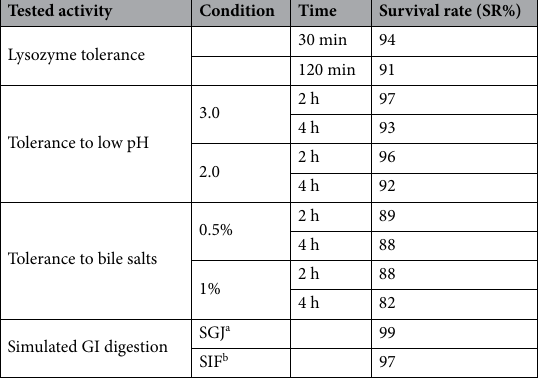
Table 1. Tolerance to lysozyme, acidic conditions, bile salts and survivability during simulated gastrointestinal transit exhibited by the tested L. rhamnosus TOM 22.8 strain. Survival rate (SR%) was calculated based on the initial and the final number of viable cells enumerated on MRS agar after 48 h. a Simulated gastric juice. b Simulated intestinal